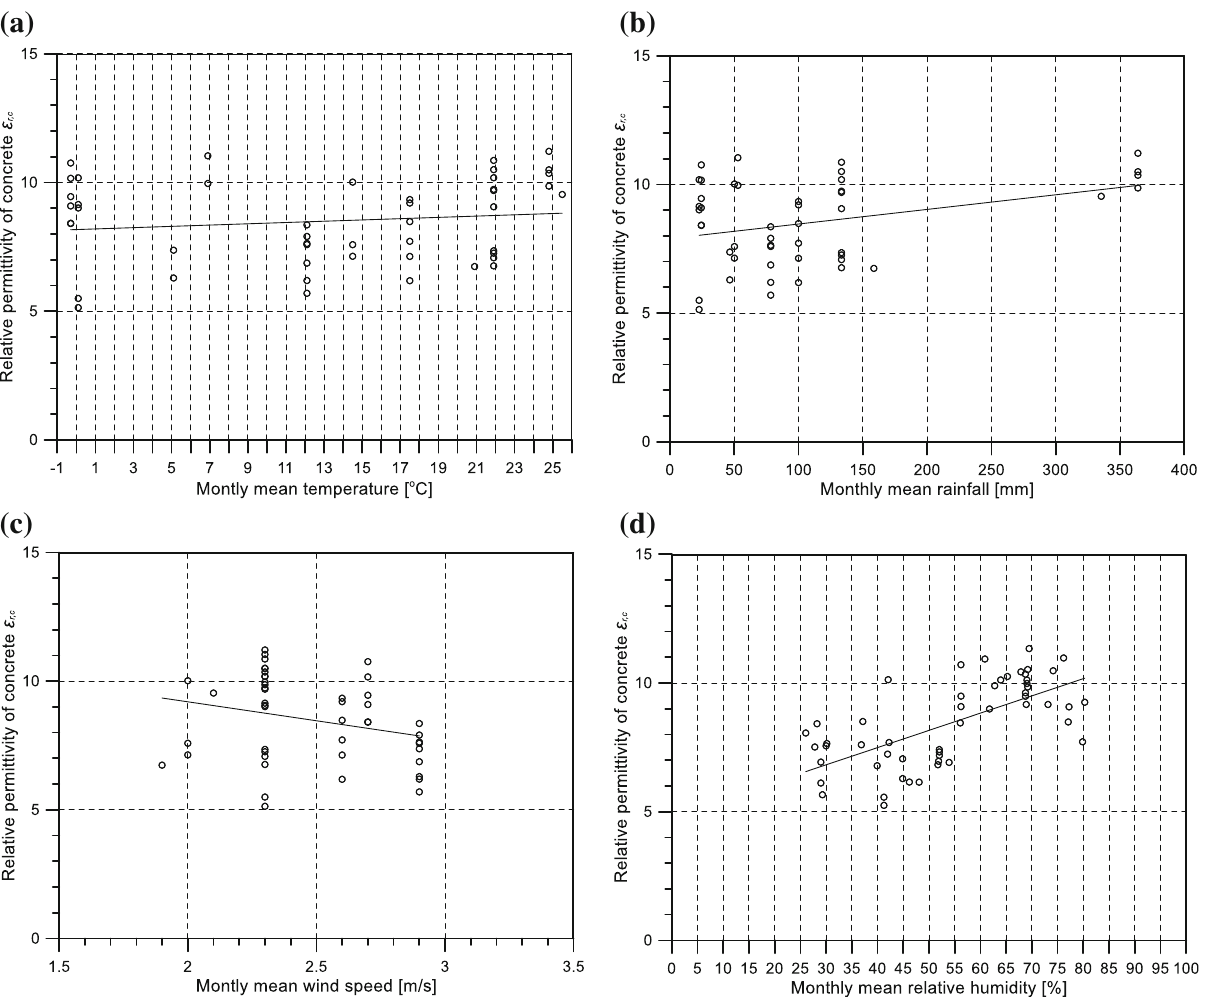
Fig. 6 Variation of the relative permittivity of concrete with different weather factors; a monthly mean temperature, b monthly mean rainfall, c monthly mean wind speed, and d monthly mean relative